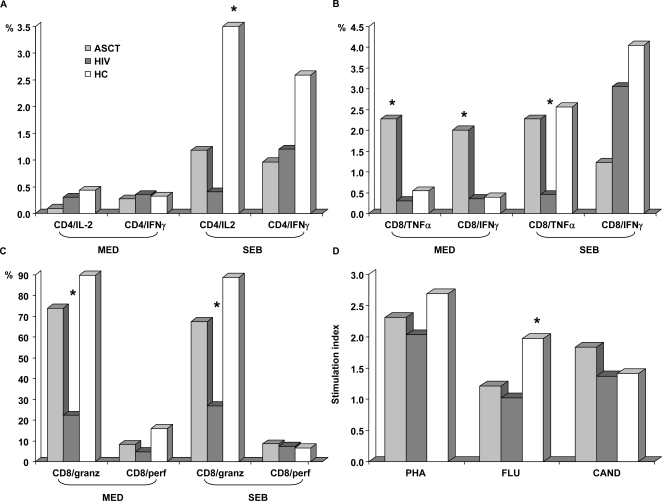
Cytokine CD4+ (A) and CD8+ (B) production, CD8+ lysis molecules expression (C) and lymphocyte proliferation (D) in ASCT recipients (ASCT), in HIV-infected patients (HIV) and in healthy controls (HC).ASCT recipients displayed significantly higher levels of TNF-α and IFN-γ producing CD8+ T cells under basal conditions and of TNF-α+ CD8+ T cells under Staphylococcal β enterotoxin (SEB) stimulation compared to HIV-infected patients. CD4+ IL-2 and IFN-γ production after SEB stimulation was globally depressed in both group of patients compared to healthy controls. The fraction of CD8+ T cells expressing granzyme B was higher in ASCT recipients than in HIV-infected patients. Antigen-induced proliferative responses showed comparable stimulation index values in both patients population and for polyclonal activation (PHA) as well as antigen stimulation (Flu, Candida), with significant difference with healthy controls regarding Flu stimulation. * = p<0.05 in the comparison between groups.